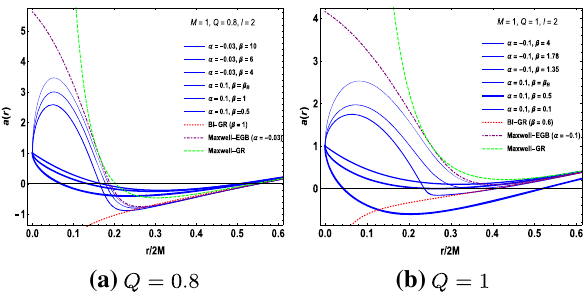
Fig. 1 The metric function a ( r ) for some parameter choices